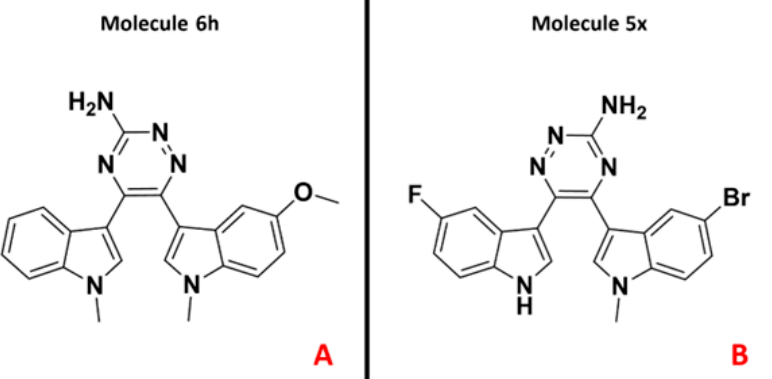
Figure 3. Representation of the two-dimensional structures of the two molecules chosen as references for the computational evaluation: 6h , a potent ligand for both PDK1 and HSP90 ( A ), and 5x , a weak binder, also in this case, for both HSP90 and PDK1 ( B ).